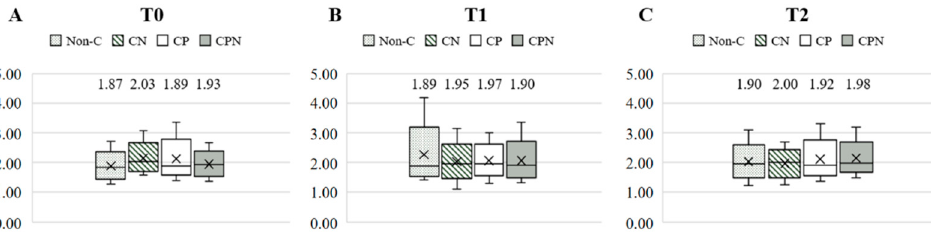
Figure 3. Comparison of the h/H among the groups at T0, T1, and T2. ( A ) T0; ( B ) T1; and ( C ) T2. h/H: hypocholesterolemic/hypercholesterolemic ratio; T0: baseline; T1: intervention; T2: follow up; non-C: no course for patients and nurses; CN: course for nurses; CP: course for patients; and CPN: course for patients and nurses. Values were presented as medians. Statistical analyses were conducted using the Kruskal–Wallis test.